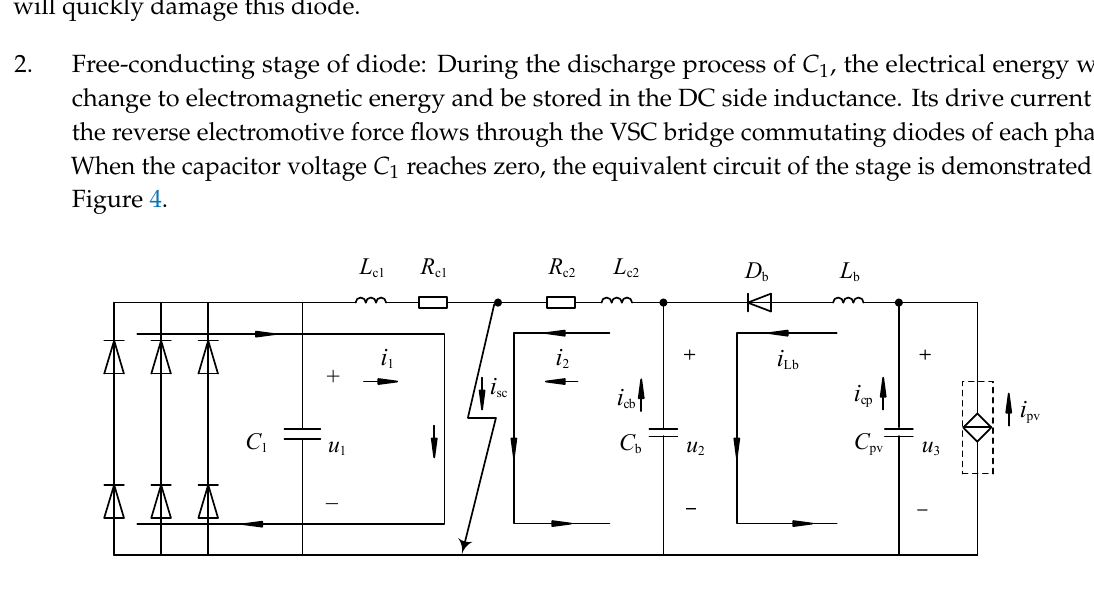
Figure 5. Equivalent circuits for the short-circuit fault at steady-state stage.